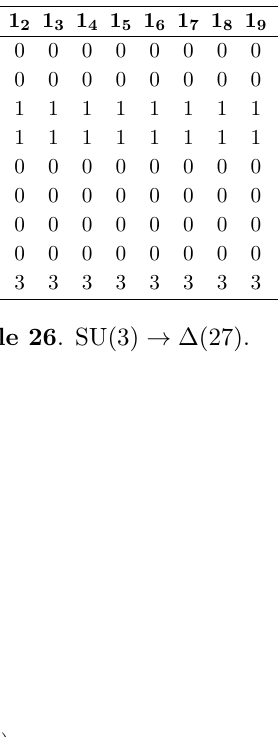
Table 27 . SU(3) ! PSL(2 ;